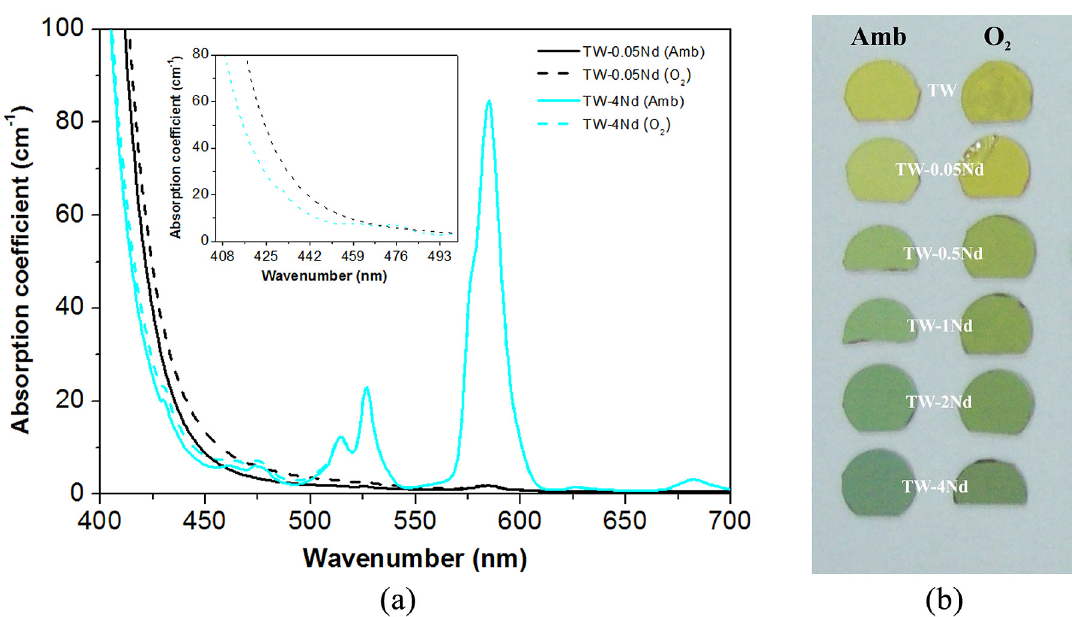
Figure 3. (a) Absorption spectrum of the TW-0.05Nd and TW-4Nd glasses and (b) Undoped and Nd 3+ -doped TW glasses, in Amb and O atmospheres. 2